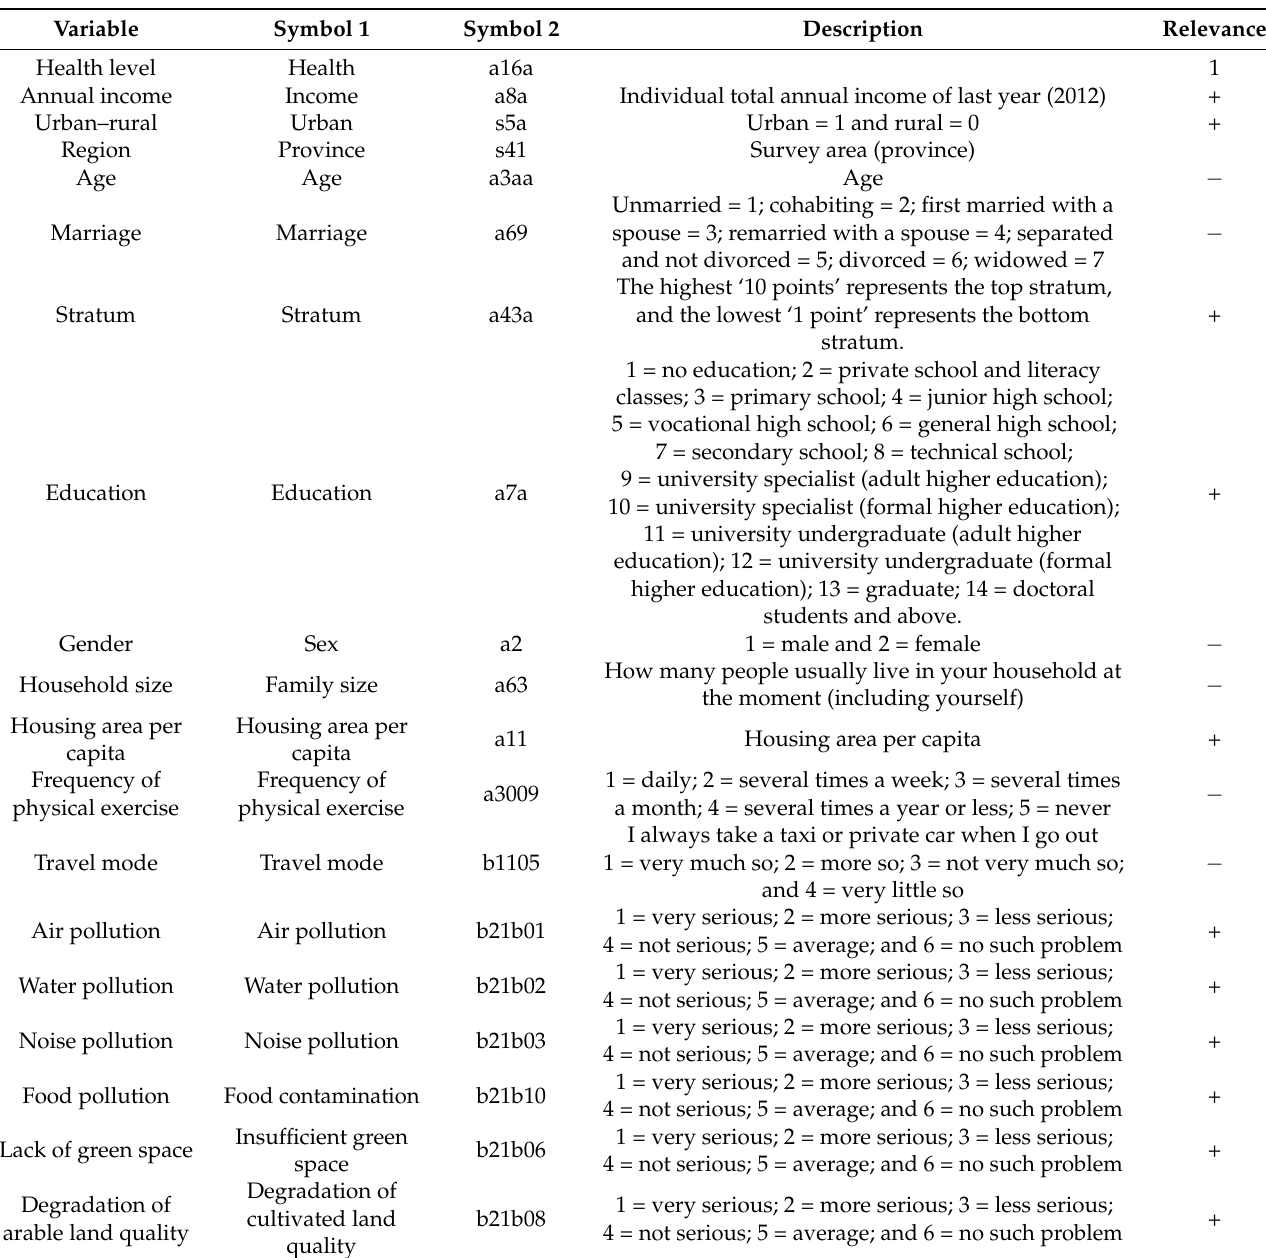
Table 1. Variable